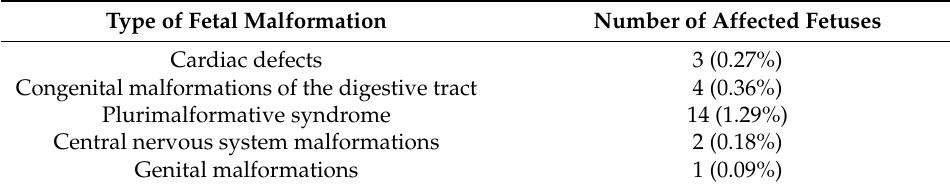
Table 3. Types of fetal malformations encountered.